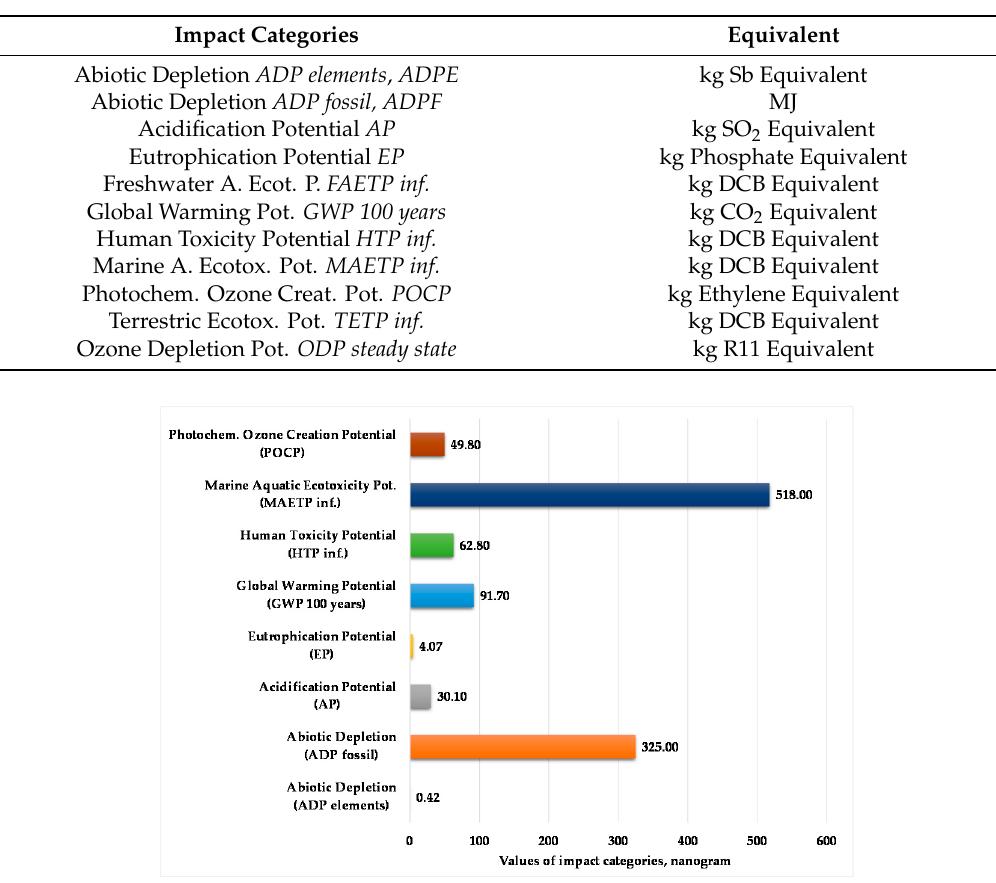
Figure 4. Values of environmental impacts in the manufacturing phase with transport. (Functional unit: 25 kg polypropylene product. Normalization reference: CML 2016 (Centrum voor Milieukunde Leiden, 2016), EU 25 + 3, year 2000, excl. biogenic carbon. Weighting method: thinkstep life cycle impact assessment (LCIA) Survey 2012, Europe, CML 2016, excl. biogenic